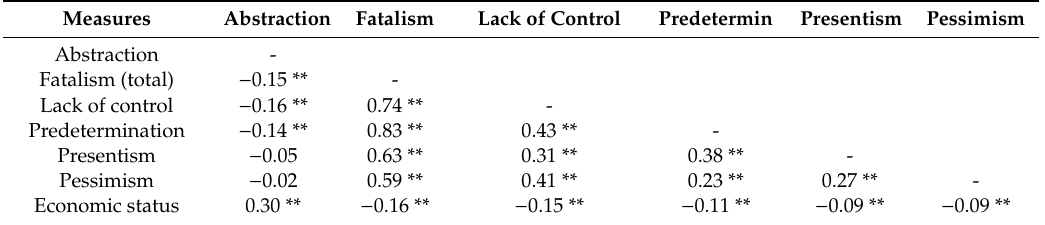
Table 1. Correlations between abstraction, economic status, fatalism score, and fatalism subscales. Measures Abstraction Fatalism Lack of Control Predetermin Presentism